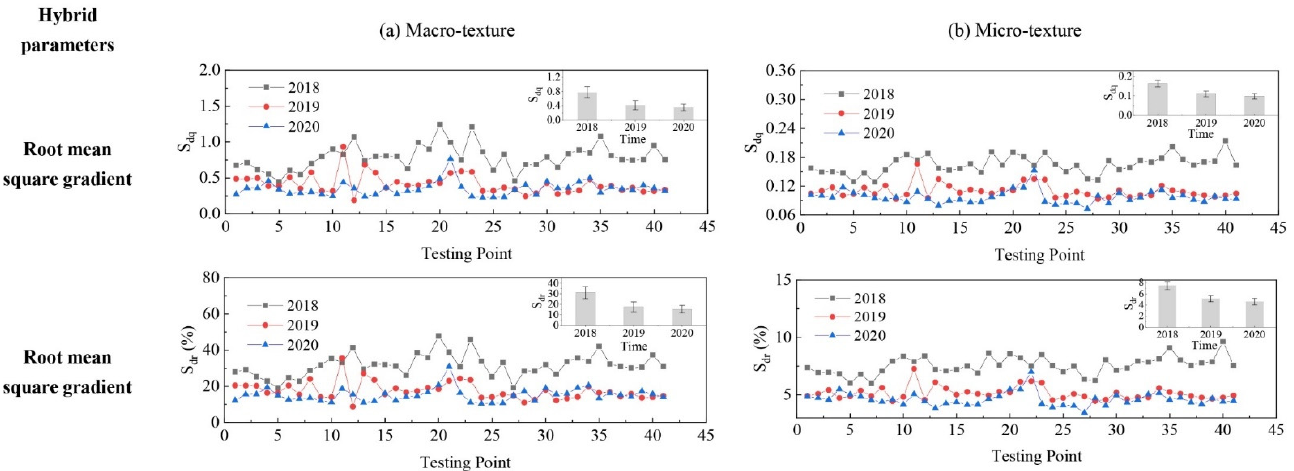
Figure 9. Pavement texture variations via hybrid parameters: ( a ) Macro − texture, and ( b ) Micro − texture.